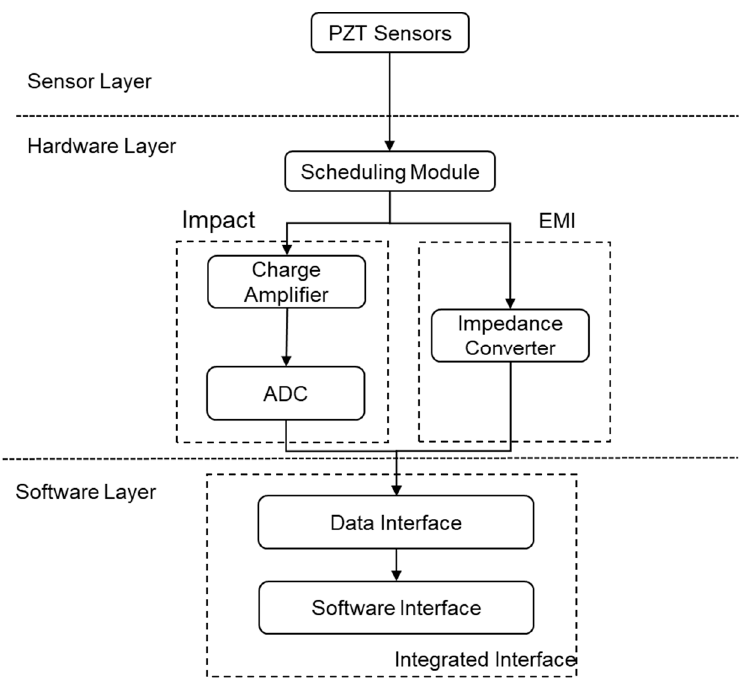
Figure 1. The architecture of the designed structural health monitoring (SHM) system.